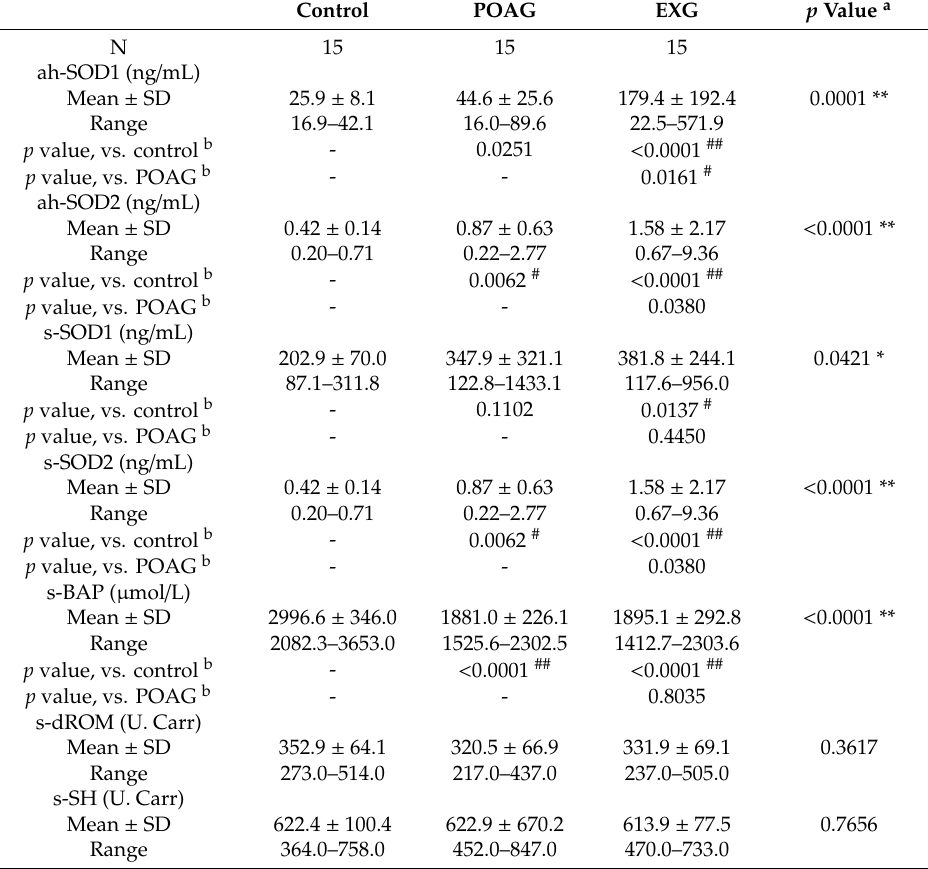
Table 2. Redox status among control, POAG, and EXG